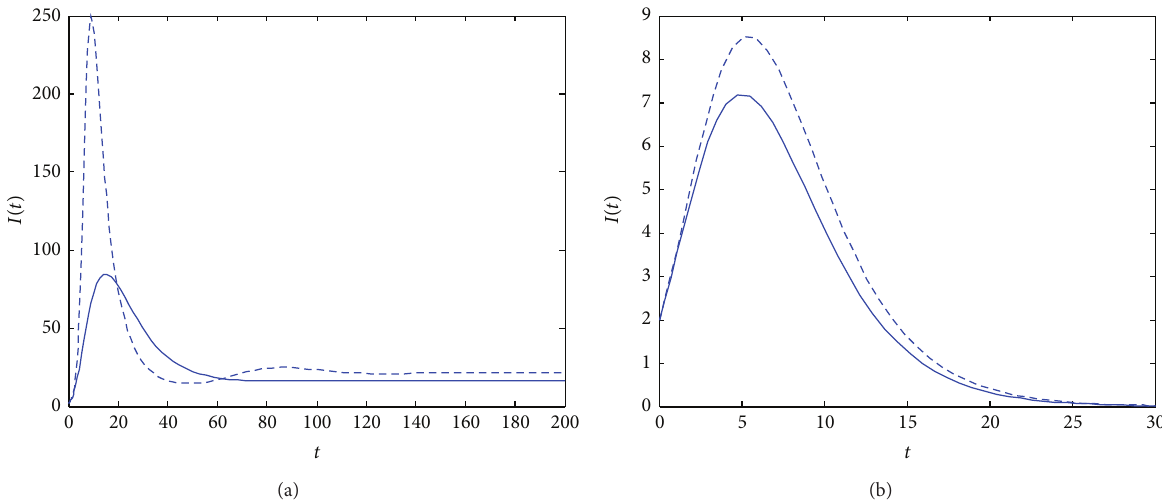
Figure 1: The tendency of the infected population varies. The solid line represents the case when 𝛽 2 = 0.0018 , and the dashed line represents the case when 𝛽 2 = 0 .